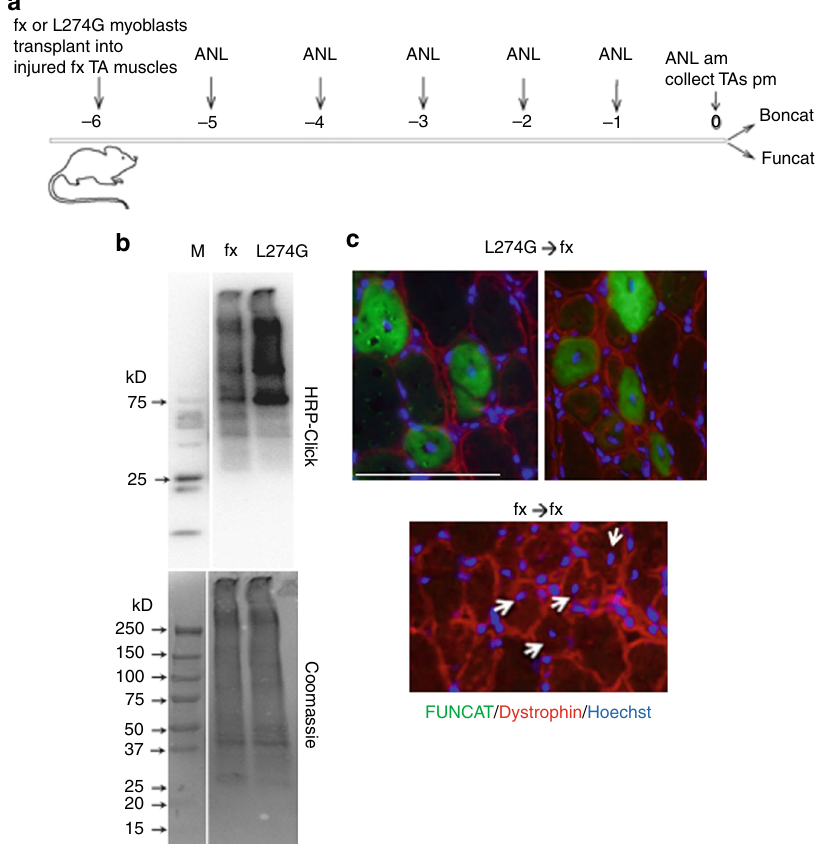
Fig. 3 Detection of newly synthesized proteins in fx muscles transplanted with MetRS L274G primary myogenic cells. a Scheme of the experimental design. The TA of fx mice were injured with dry ice. Primary myogenic cells derived from MetRS L274G or fx mice were transplanted into the injury sites. ANL was injected for 6 consecutive days I.P. into transplanted animals after which TA muscles were collected. b Click-chemistry western blotting on lysates of fx muscles that were transplanted with MetRS L274G versus fx myogenic cells detects ANL-tagged proteins (smearing) in the MetRS L274G samples, as compared to the background signal of fx protein lysates. Coomassie blue staining served as a loading control. Similar results were obtained in three independent experiments. c FUNCAT assay in conjunction with anti-dystrophin immuno fl uorescence and Hoechst nuclear co-stain were performed, as above. The ANL labeling ( green fl uorescence) of dystrophin positive ( red outlines ) myo fi bers that have been recently regenerated (central Hoechst positive nuclei) was reliably detected in fx TAs that were transplanted with the primary MetRS L274G myoblasts. The negative controls, fx TAs that were transplanted with fx primary myobalsts were FUNCAT negative, while as expected, dystrophin positive and with central nuclei at the sites of transplantation ( white arrowheads ). Similar results were obtained in three independent experiments. Scale bar , 100 μ